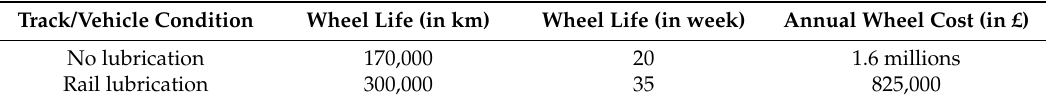
Table 1. Reduction of wheel maintenance due to lubrication